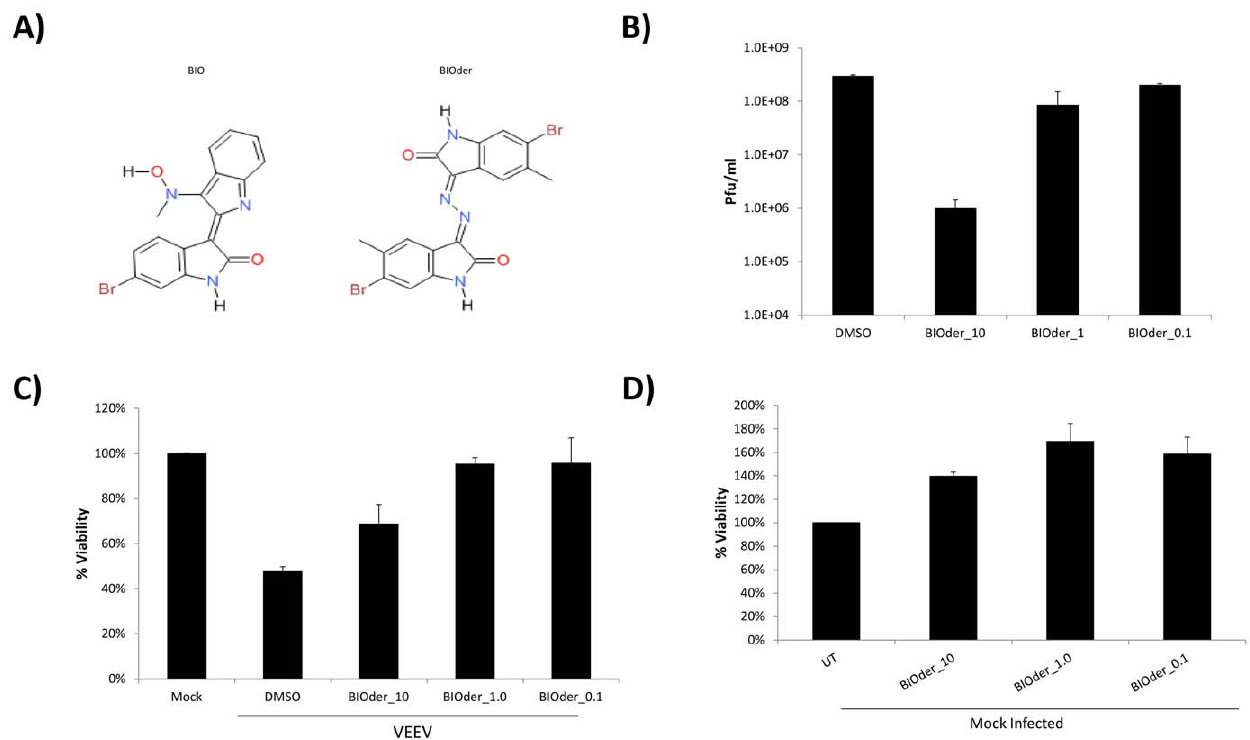
Figure 3. Characterization of BIOder. A ) Structure of BIO: 6-bromoindirubin-3 9 -oxime and BIOder ( # 6): 6-bromo-5-methyl-1H-indole-2,3-dione 3. B ) U87MG astrocytes were pretreated for 2 hours with DMSO or BIOder (10, 1.0, and 0.1 m M), infected with VEEV TC-83 at MOI 0.1, and post-treated. Twenty-four hours post-infection, supernatants were collected and analyzed by plaque assay to determine the amount of infectious virus released. C ) U87MG astrocytes were pretreated for 2 hours with DMSO or BIOder (10, 1.0, and 0.1 m M), infected with VEEV TC-83 at MOI 0.1, and post-treated. Seventy hours post infection, CPE was measured by MTT assay. Mock infected cells are displayed at 100% viability. D ) Uninfected U87MG astrocytes were treated with BIOder (10, 1.0, and 0.1 m M), and cell viability determined by MTT assay. Untreated (UT) cells are displayed at 100% viability.